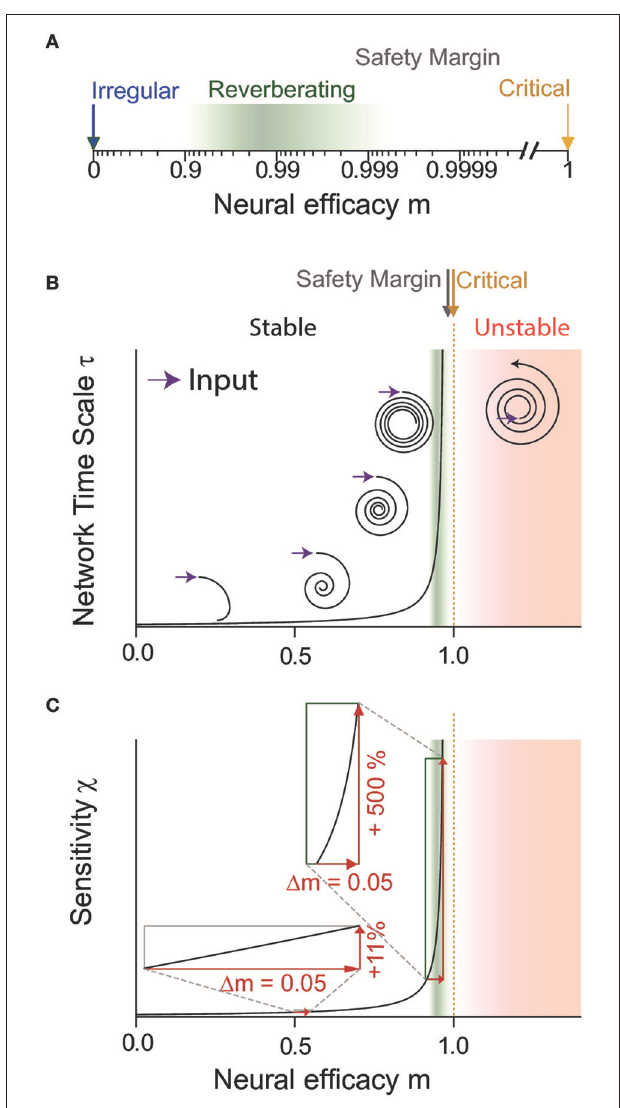
FIGURE 2 | The neural efficacy m determines the average impact any spike has on the network. Depending on m , network dynamics can range from irregular ( m 0) to critical ( m 1) and unstable ( m > 1) dynamics. (A) In a = = logarithmic depiction of m , the “reverberating regime” (green) observed for cortex in vivo is well visible. It has clearly a larger m than the irregular state (blue), but maintains a safety margin to criticality (yellow) and the instability associated with the supercritical regime (red in B , C ). (B,C) Sketch to illustrate the divergence of dynamical and computational properties at a critical phase transition, at the example of the network timescale and the sensitivity, respectively. (B) The network timescale determines how long input is maintained in the network. While any rate change is rapidly quenched close to the irregular state ( m 0), input “reverberates” in the network activity for = increasingly long timescales when approaching criticality ( m 1). In the = reverberating regime, the network timescale is tens to hundreds of milliseconds. For m > 1, input is amplified by the network, implying instability (assuming a supercritical Hopf bifurcation here for illustration). The reverberating regime keeps a sufficient safety margin from this instability. (C) The reverberating regime found in vivo allows large tuning of the sensitivity by small changes of the neural efficacies (e.g., synaptic strength or excitation-inhibition balance), in contrast to states further away from criticality